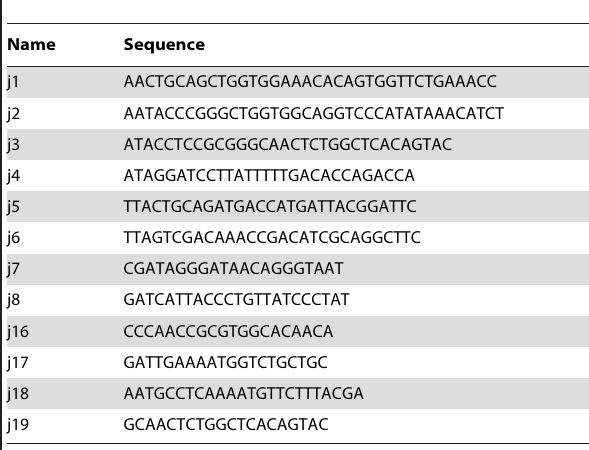
Table 2. Sequence of the oligonucleotides used in this